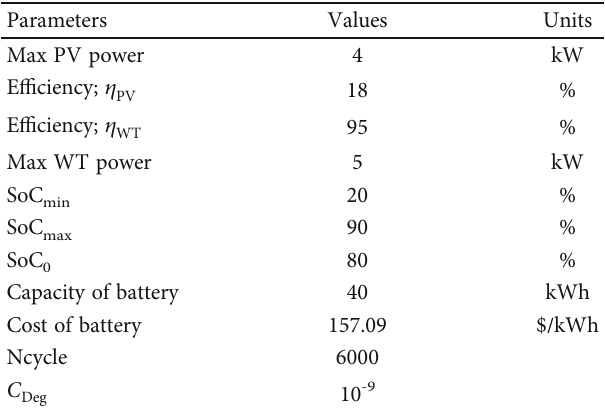
Figure 7: Flow chart of the Pattern search algorithm. Table 2: Parameters of the proposed hybrid